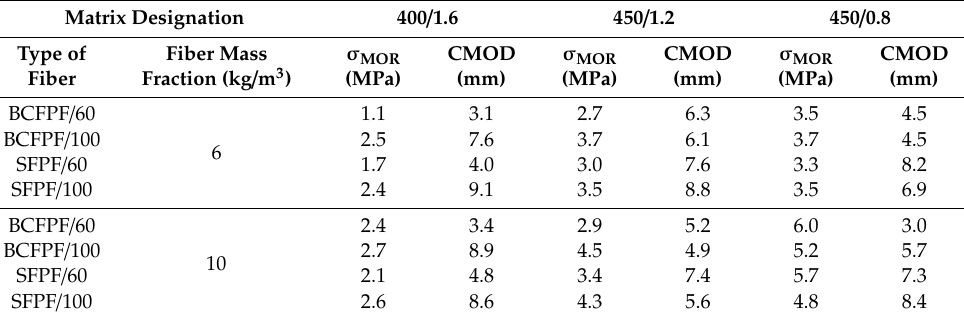
Table 8. Comparison of σ MOR stress values and the corresponding CMOD